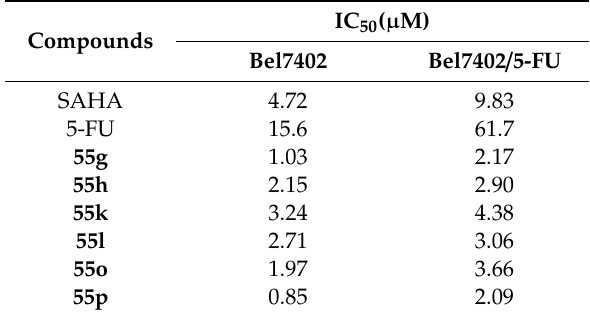
Table 6. IC 50 values of compounds 55g,h , 55k,l , and 55o,p against drug-sensitive HCC Bel7402 and drug-resistant HCC Bel7402/5-FU cells [30].